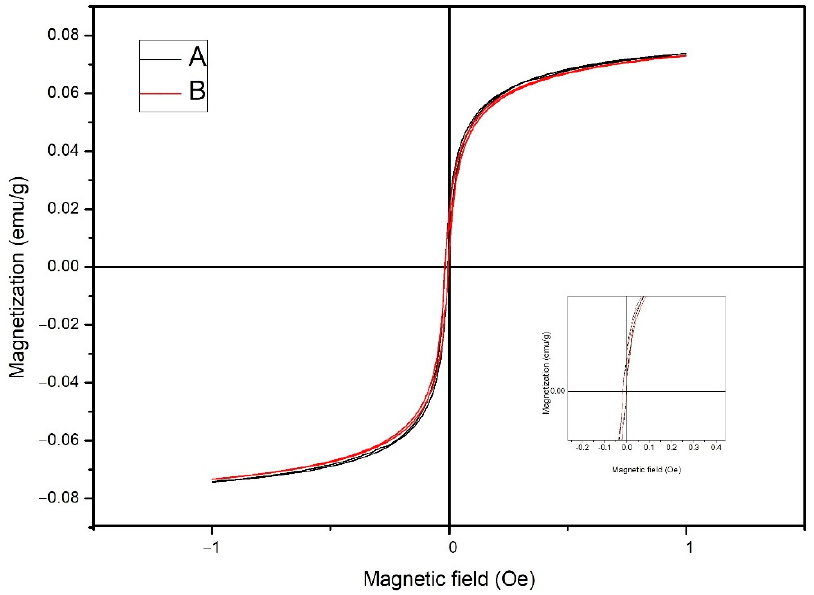
Figure 5. Hysteresis curves ( A ) of jabon wood with a magnetic charge created in-situ with a strong base precursor (black line) and ( B ) magnetically charged jabon wood created in-situ with a weak base precursor (red line).